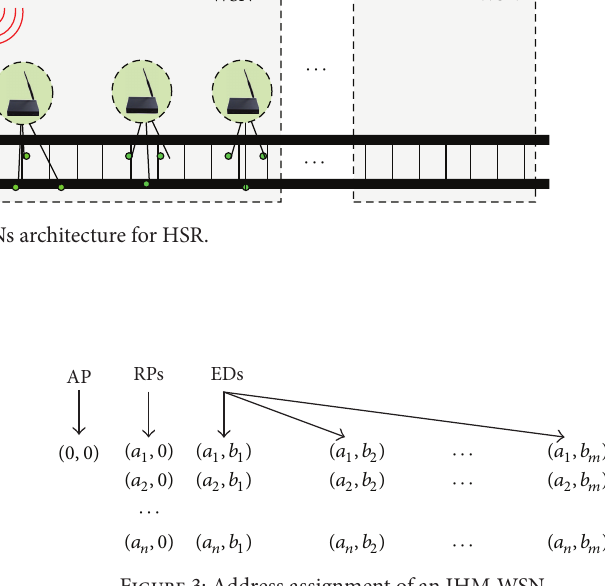
Figure 3: Address assignment of an